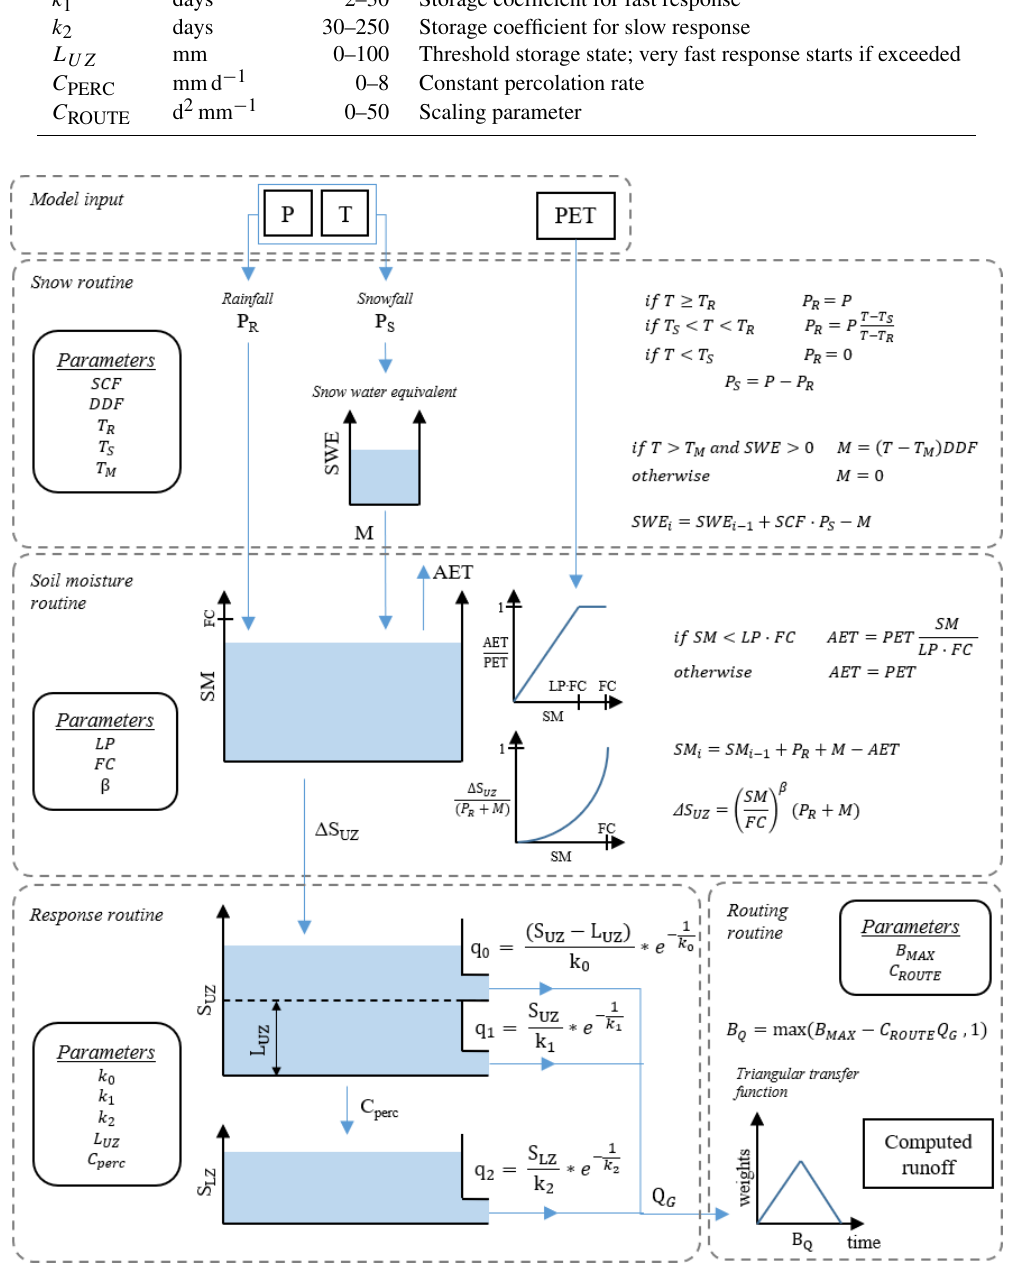
Figure 2. TUW model scheme – lumped